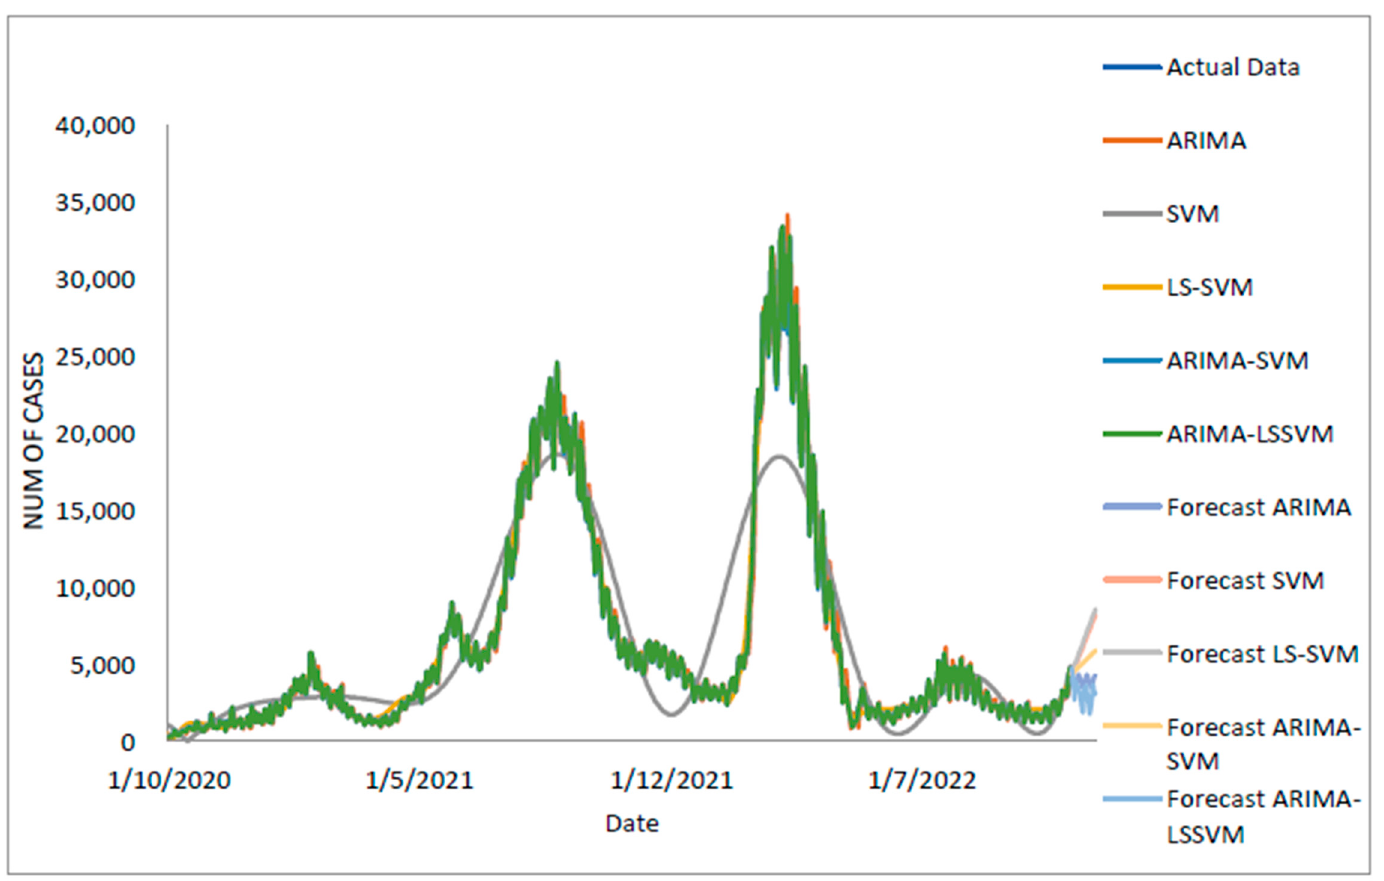
Figure 5. Actual and three weeks ahead forecasted values of ARIMA, SVM, LSSVM, ARIMA–SVM, and ARIMA–LSSVM models for new cases of COVID-19 of the 80% training and 20% testing set